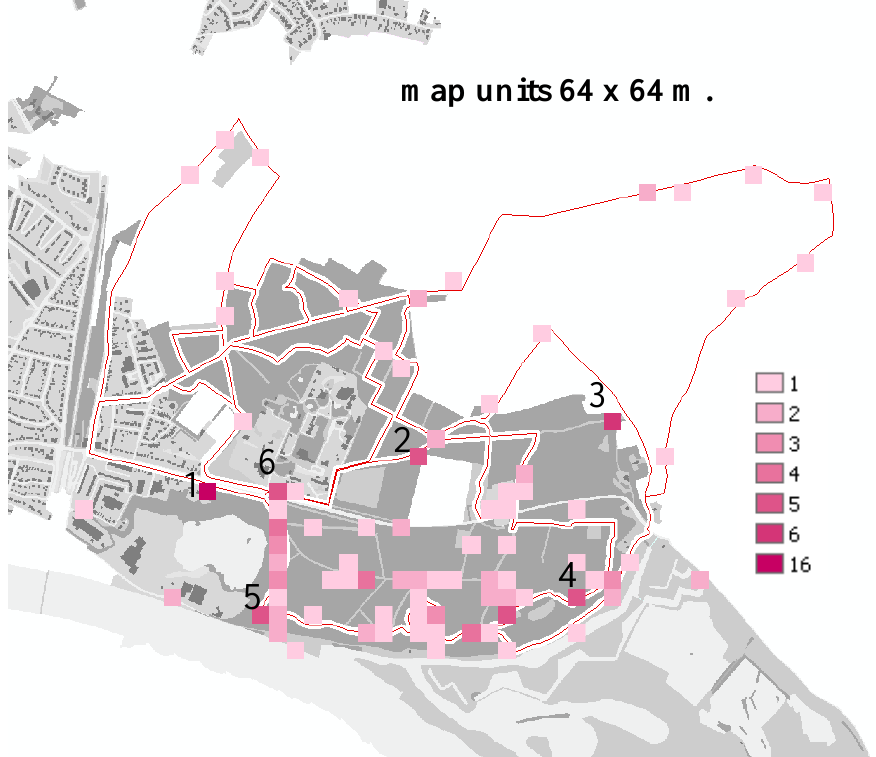
Figure 7. PP density per map unit (64 × 64 meters).